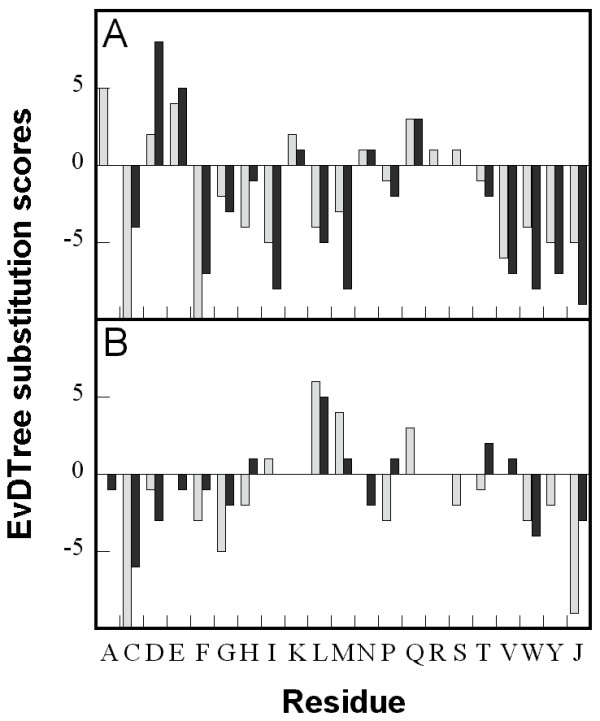
Substitution profiles for 4 different EvDTree clusters. (A) Two profiles for different amino acids (Ala and Asp) in similar structural environments corresponding approximately to an exposed α-helix. Grey bars: Ala with pac > 38 and ss1 = 1; Black bars: Asp with pac > 20 and ss2 = 1. (B) Two profiles for the same amino acid (Leu) in different structural environments. Grey bars: Leu with pol > 53 and ss1 = 1; Black bars: Leu with pol > 53 and ss1! = 1.